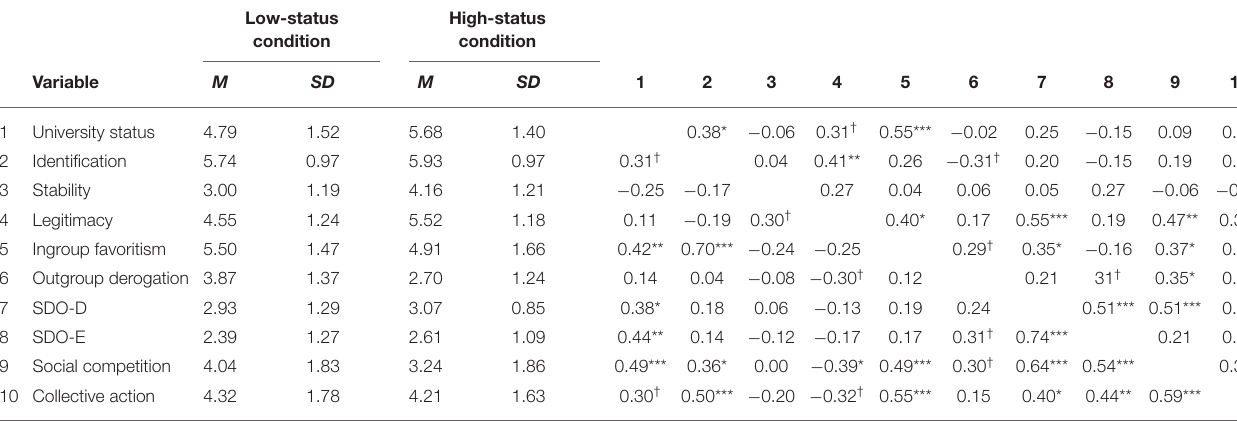
TABLE 1 | Summary of means, standard deviations, and correlations between measures by ingroup status condition.